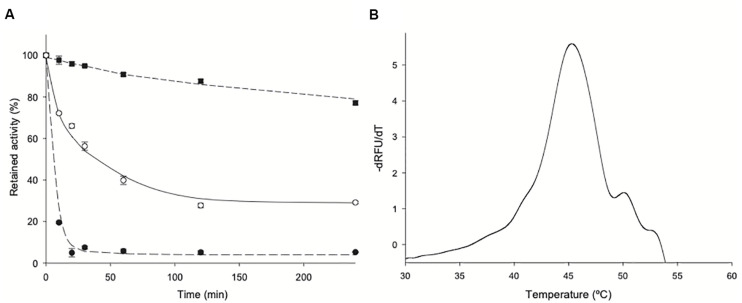
(A) Thermal inactivation of ZgHGPRT/AMPK at (■) 40°C, (∘) 50°C and (•) 60°C. (B) Melting temperature of ZgHGPRT/AMPK. All determinations were carried out in triplicate and the maximum standard deviation value was 1.8%.